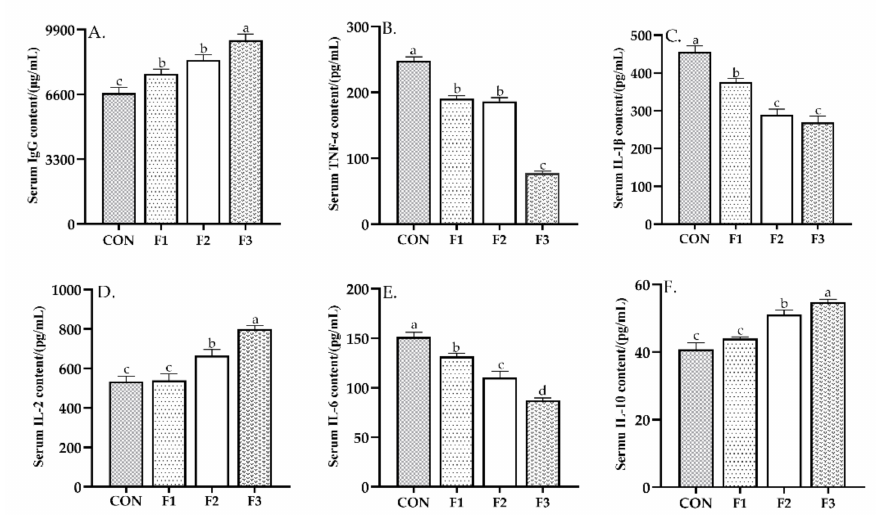
Figure 2. Effects of dietary fucoidan administration for 30 days on serum immunity indexes in weaned kids. ( A ) serum IgG content; ( B ) serum TNF- α content; ( C ) serum IL-1 β content; ( D ) serum IL-2 content; ( E ) serum IL-6 content; ( F ) serum IL-10 content. Results are presented as mean ± SEM ( n = 6). a–d means significantly different ( p < 0.05). CON, basal diet; F1, basal diet +0.1% fucoidan; F2, basal diet +0.3% fucoidan; F3, basal diet +0.5% fucoidan. IgG, Immunoglobulin G; TNF- α , tumor necrosis factor- α ; IL-1 β , interleukin-1 β ; IL-2, interleukin-2; IL-6, interleukin-6; IL-10, interleukin-10.